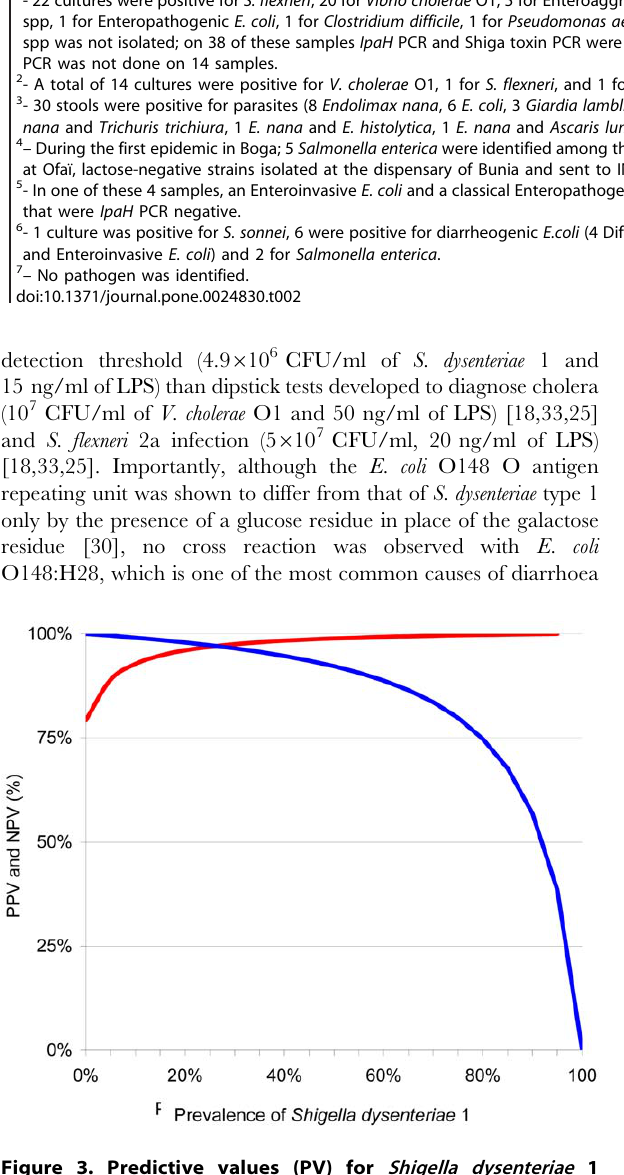
Figure 3. Predictive values (PV) for Shigella dysenteriae 1 diagnosis. Positive PV is represented by the red line and negative PV by the blue line.